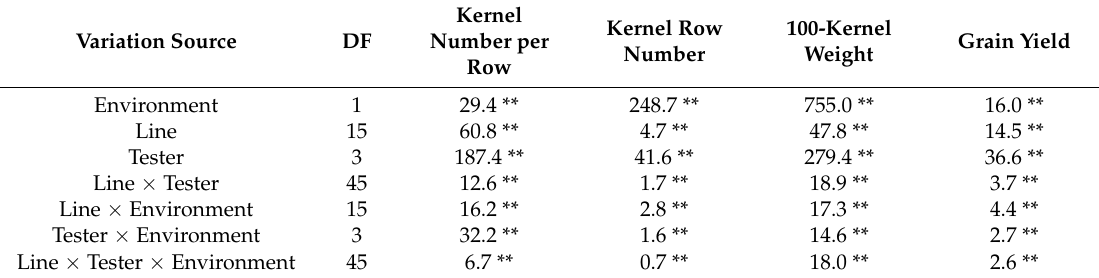
Table 9. Analysis of variance for the yield characteristics of the hybrids derived from USA maize inbred lines crossed with China inbred testers grown in two locations in 2015. DF